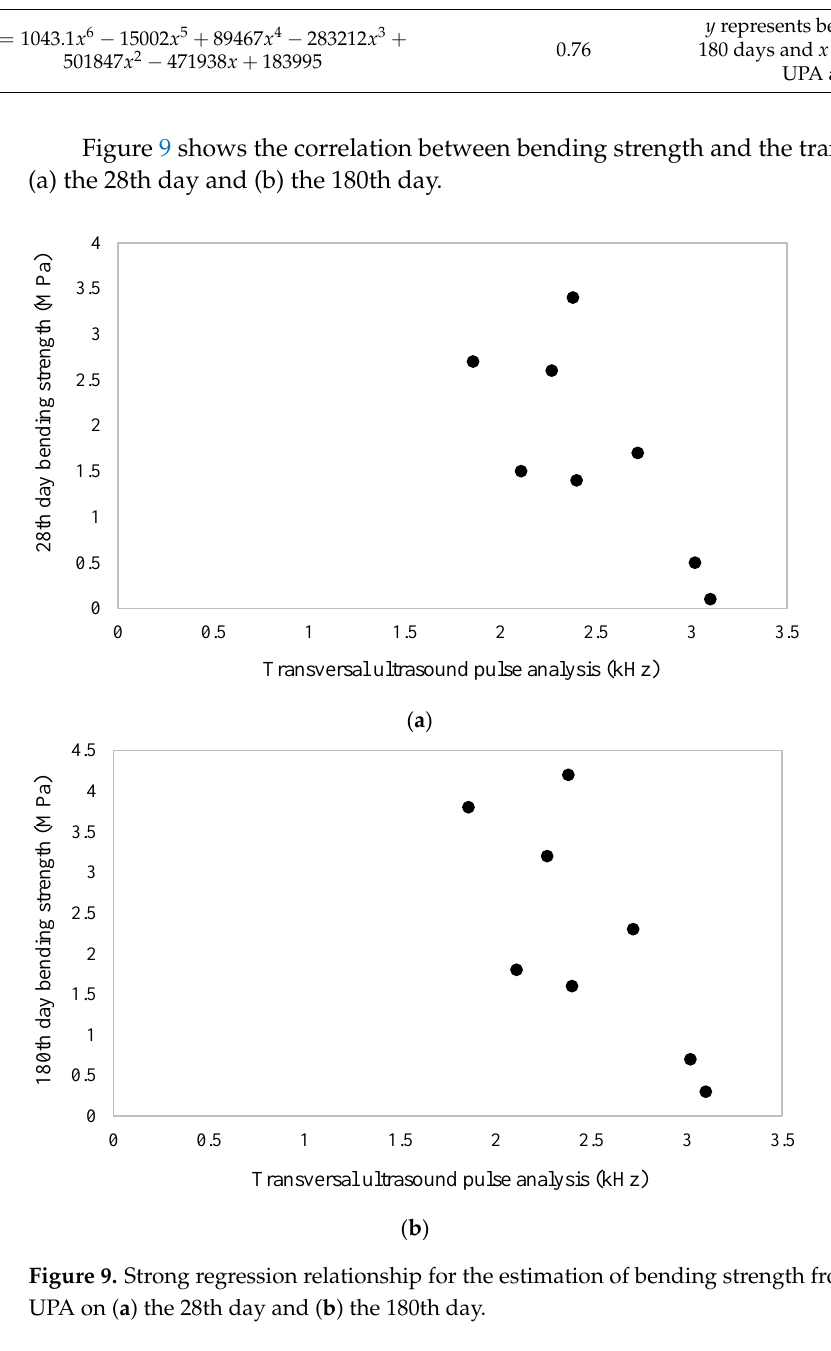
Table 7. Calibration equations for predicting bending strength from transversal UPA. N u m b e r